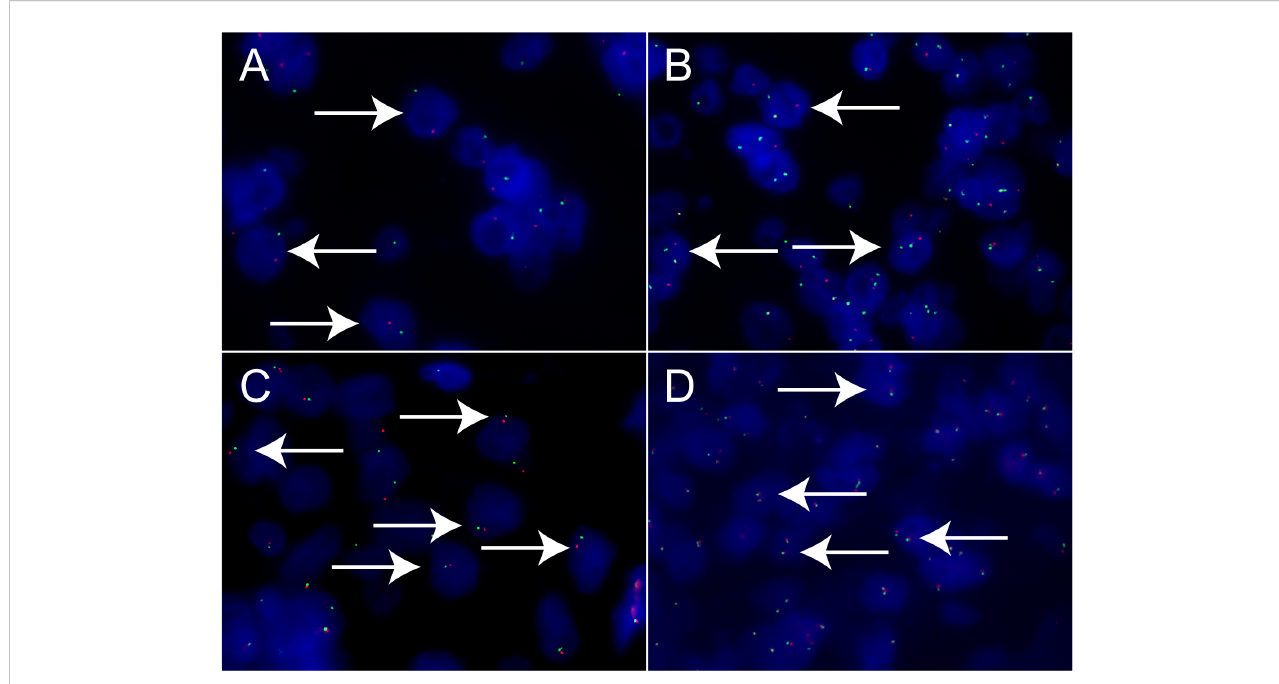
FIGURE 3 Results of TFE3 break-apart FISH in Xp11.2 tRCC. (A, B) Typical signal patterns in a male case (1R1G) and a female case (1R1G1F). (C, D) Equivocal signal patterns of NONO-TFE3 in a male case (1R1G) and a female case (1R1G1F). Original magni fi cation: × 1000 (A – D) . R, red; G, green; F, fusion; FISH, fl uorescence in situ